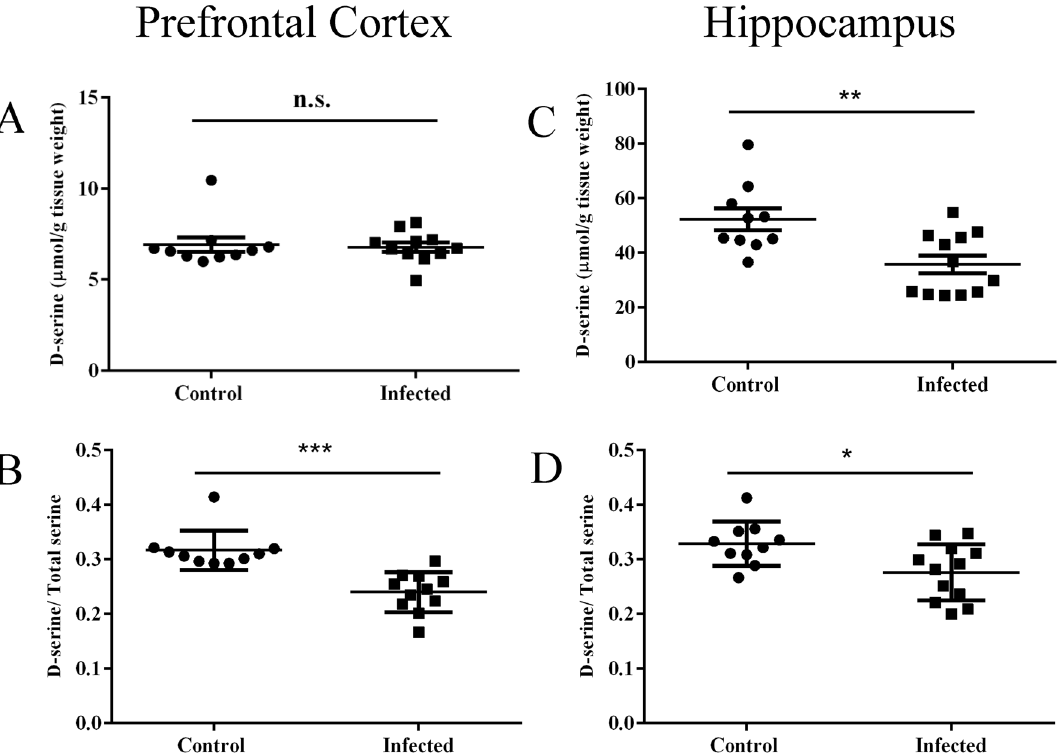
Figure 5. Reduction of D-serine in prefrontal cortex and hippocampus in T. gondii chronic infection. D-serine levels are reduced in the hippocampus ( C ) and unchanged in prefrontal cortex ( A ). D-serine/total serine ratio was reduced in both prefrontal cortex ( B ) and hippocampus ( D ). Asterisks indicate statistically significant differences and N.S. not significance. * p < 0.05, ** p < 0.01; *** p < 0.001. Symbols correspond to individual subjects. Horizontal lines represent mean values for each group. Prefrontal cortex: control (n = 10), infected (n = 11). Hippocampus: control (n = 7), infected (n =